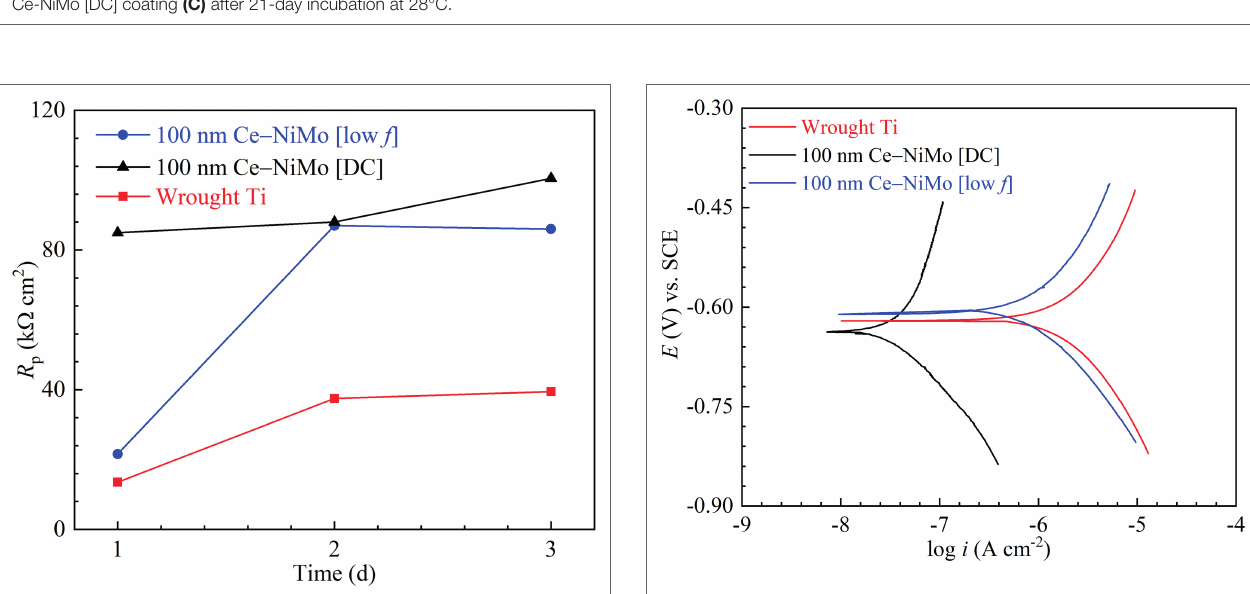
FIGURE 7 | CLSM biofilm images showing GHB cells (green dots for cells and red dead) on wrought uncoated Ti surface (A) , NiMo [DC] coating (B) , and 100 nm Ce-NiMo [DC] coating (C) after 21-day incubation at 28 ° C.